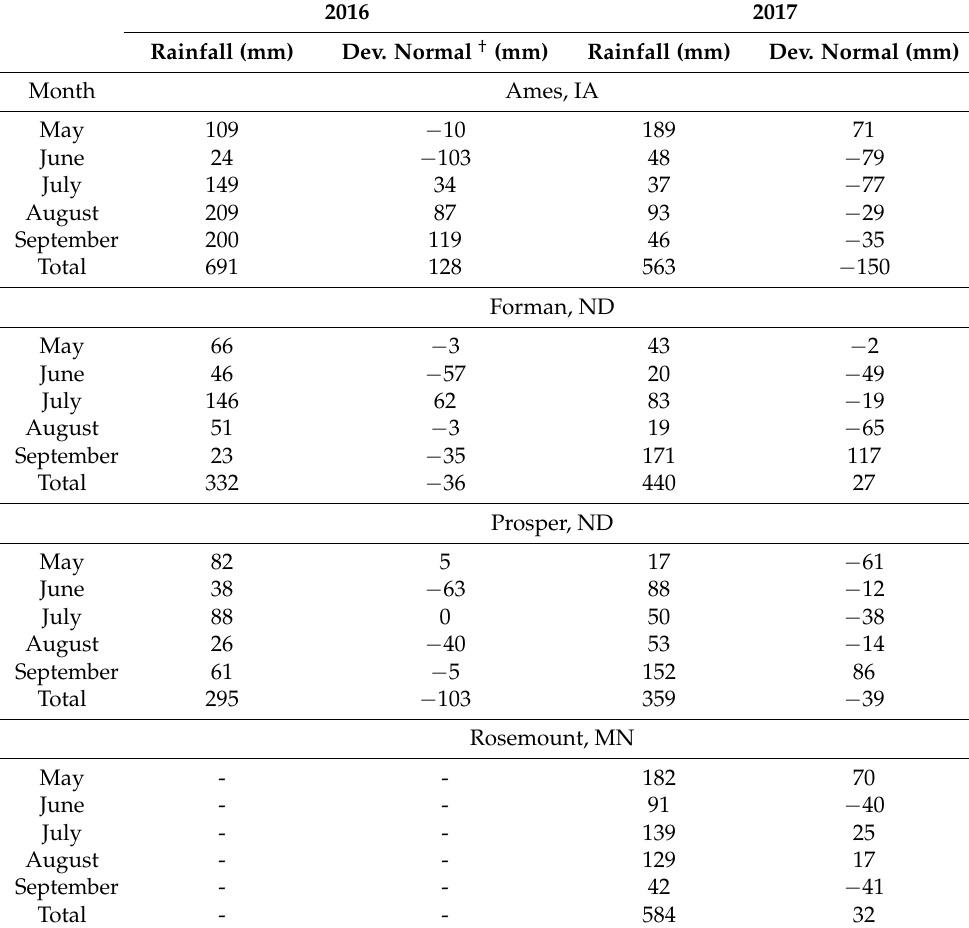
Table 12. Accumulated rainfall and deviation from normal rainfall in 2016 and 2017 from May to September at Fargo, Prosper, ND, Ames, IA, and Rosemount